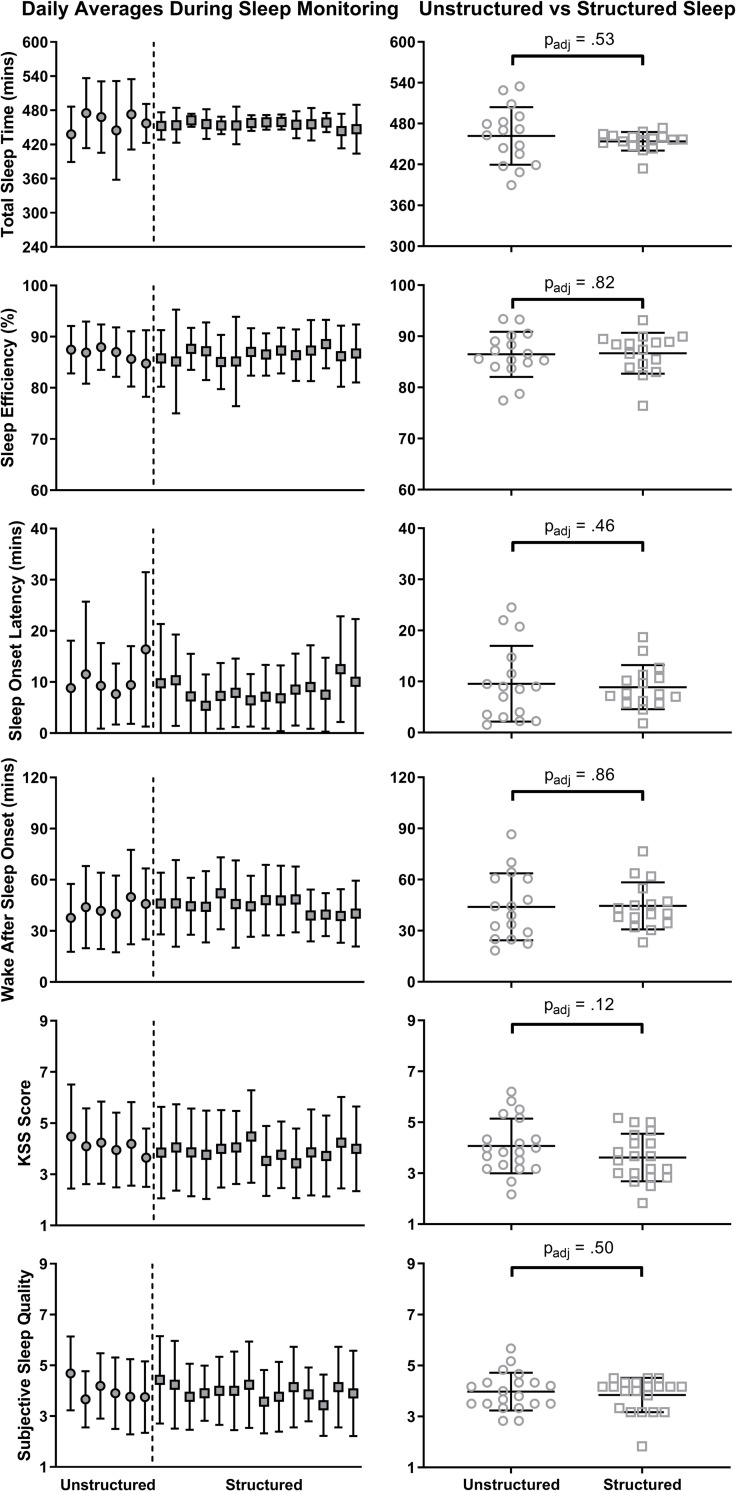
Actigraphy scored sleep outcomes in unstructured and structured sleep.Left column: Night-to-night changes in sleep outcomes (symbol = mean, error bars = SD). Unstructured Sleep: Left of vertical line, with circle symbols; Structured Sleep: right of vertical line, with square symbols. Right column: Comparison of outcomes between Unstructured (circles) and Structured (squares) Sleep. Black lines show mean and SD; symbols show individual data. padj: False Discovery Rate adjusted p-value; *Statistically significant result.